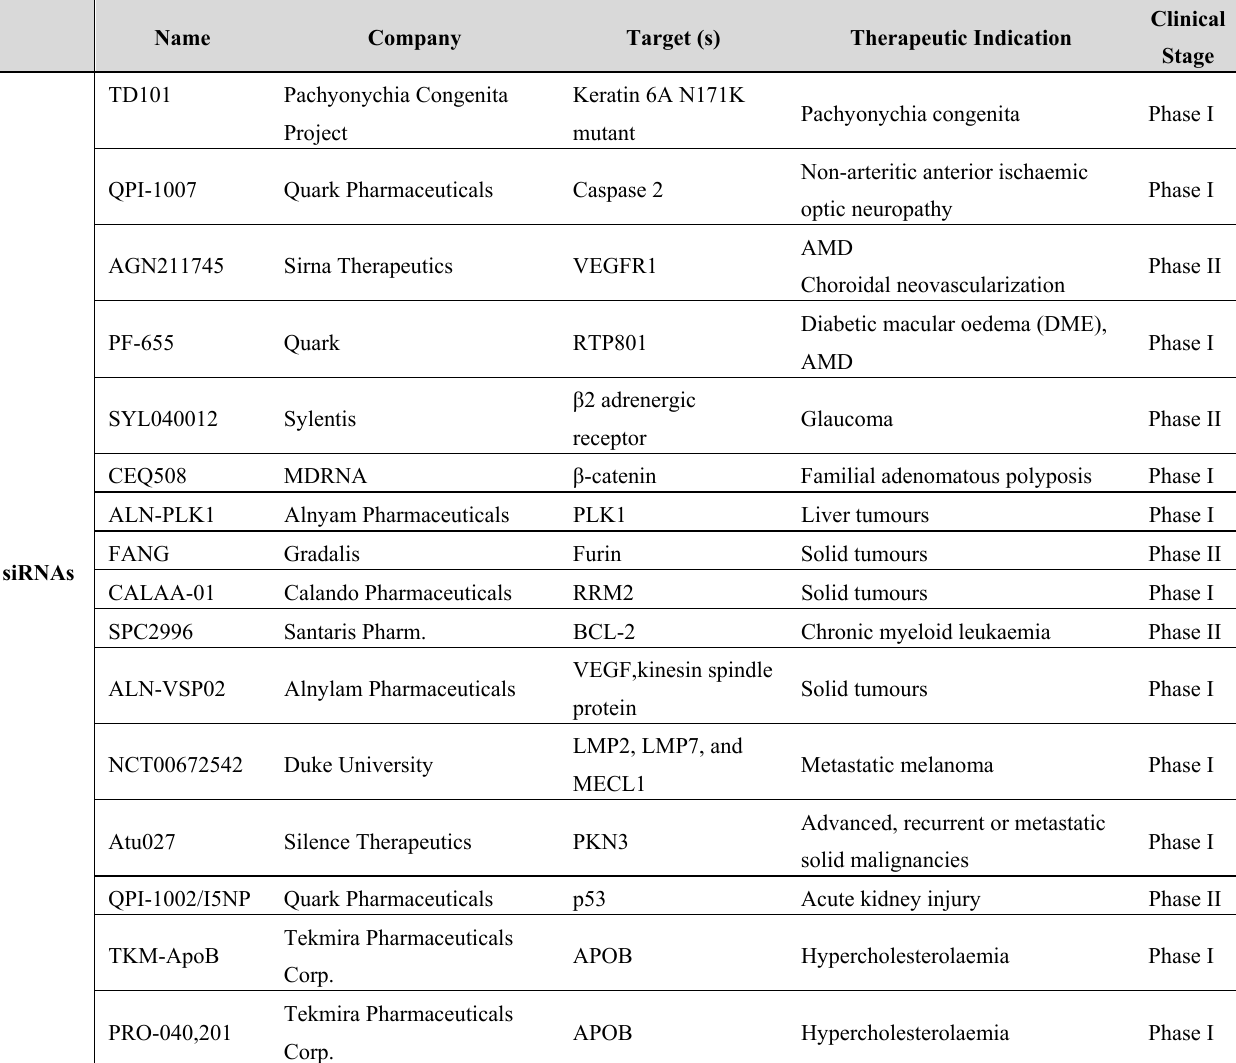
Table 1. siRNAs and aptamers in clinical